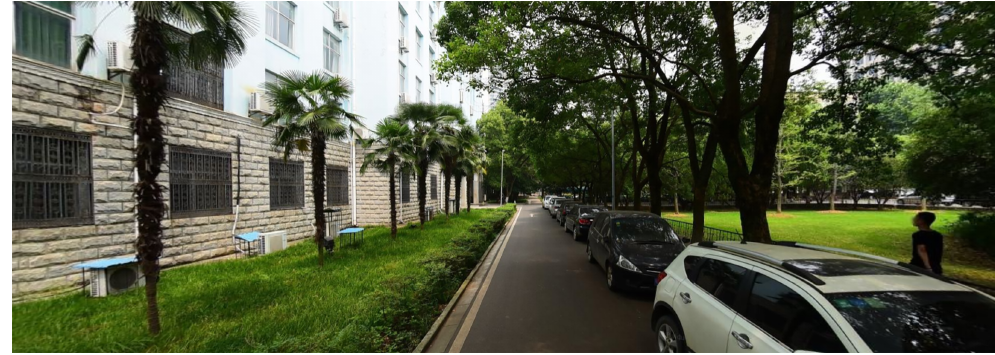
Figure 22. Scenario where vertical error of GIDCSR